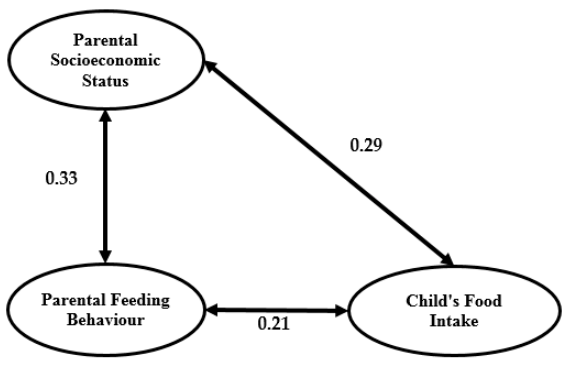
Figure 4. Full measurement model.